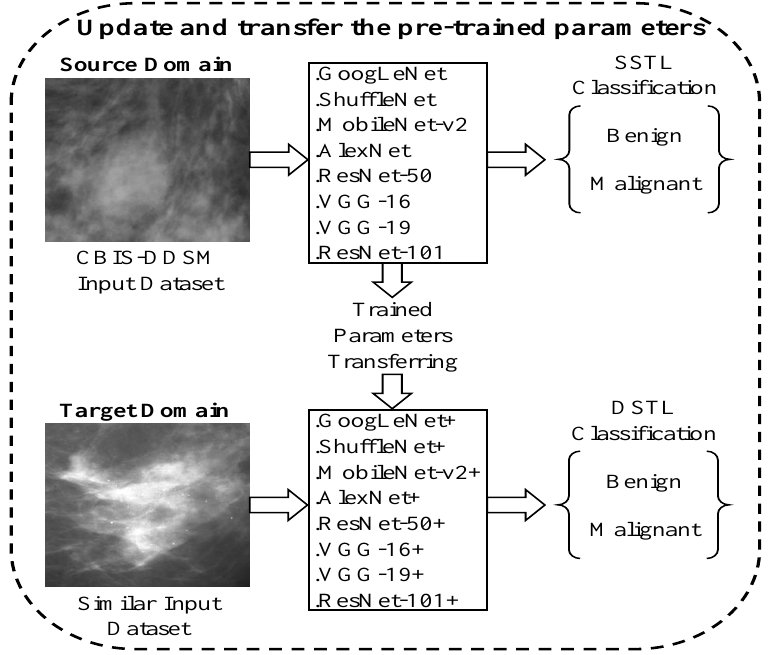
Figure 5. The process of DSTL, where various pre-trained models were first fine-tuned on a large number of the augmented CBIS-DDSM dataset to update their weights and biases parameters. Second, the updated pre-trained models were fine-tuned on a new and similar dataset to classify between benign and